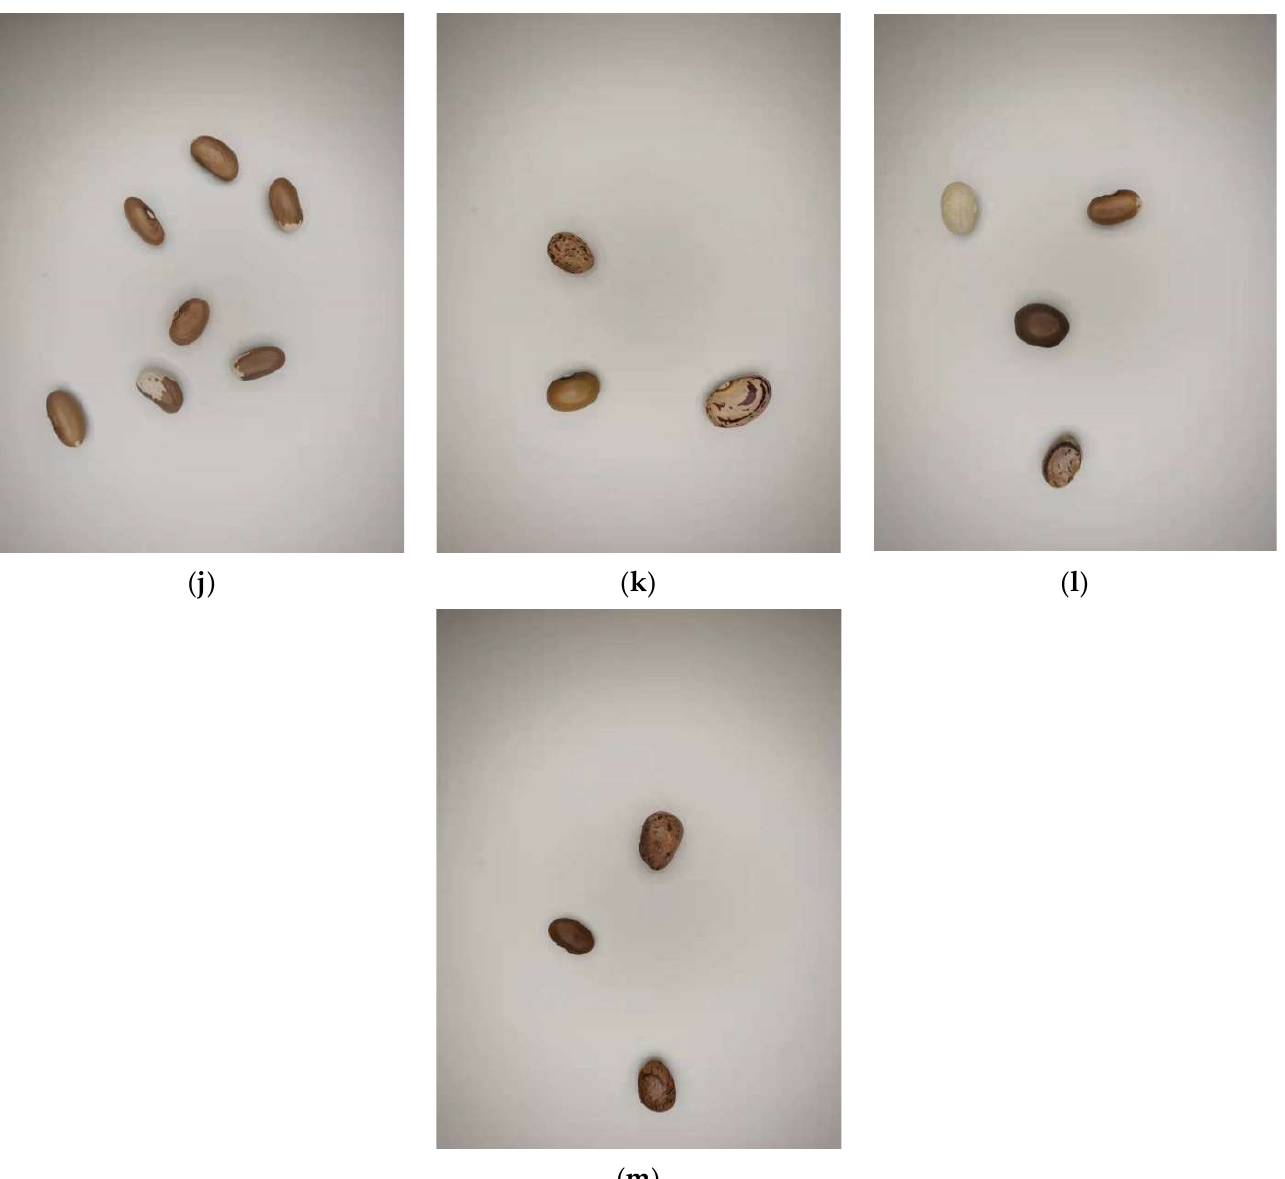
Figure 2. The dataset of single-class and multi-class seeds: ( a ) bayuelv; ( b ) cuiguan; ( c ) dazihua; ( d ) fengguan; ( e ) hongguan; ( f ) jinguan; ( g ) juguan; ( h ) qingguan; ( i ) taikongdou; ( j ) yuguan; ( k ) com- bination of juguan, cuiguan, and hongguan seeds; ( l ) combination of taikongdou, qingguan, and fengguan; and ( m ) combination of bayuelv, yuguan, dazihua, and jinguan. Different kinds of kidney bean seeds were labeled using the labeling tool LabelImg; the weights were obtained by training and testing according to the test set. The images of this dataset were processed into a JPG format, and the seeds of each species were labeled with the image processing tool LabelImg. Then, TXT files were generated by the LabelImg software to output the seed ID and coordinate location information, as presented in Figure 3. In Figure 3d, each row represents a seed that was labeled, and the labeled box was generated. From 0 to 3, the four categories of seeds were represented. The other four data in each row represent the center coordinates of the labeled box relative to the image, and the width and height of the labeled box relative to the image.